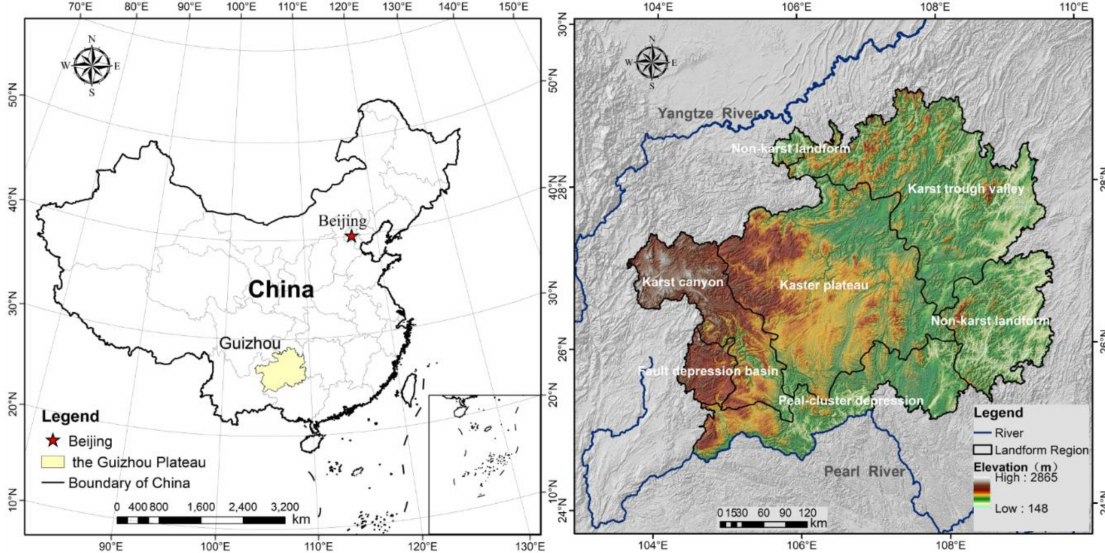
Figure 1. Location of the study area in China ( left ) and the landform regions on the Guizhou Plateau ( right